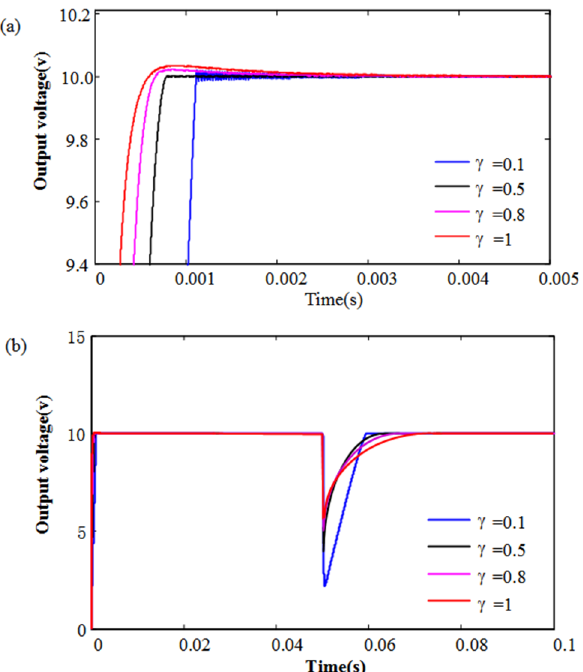
Fig 2. The output voltage dynamic response with different γ . (a) The output voltagedynamic responsein start-up; (b) The output voltagedynamic responseduringload variations.